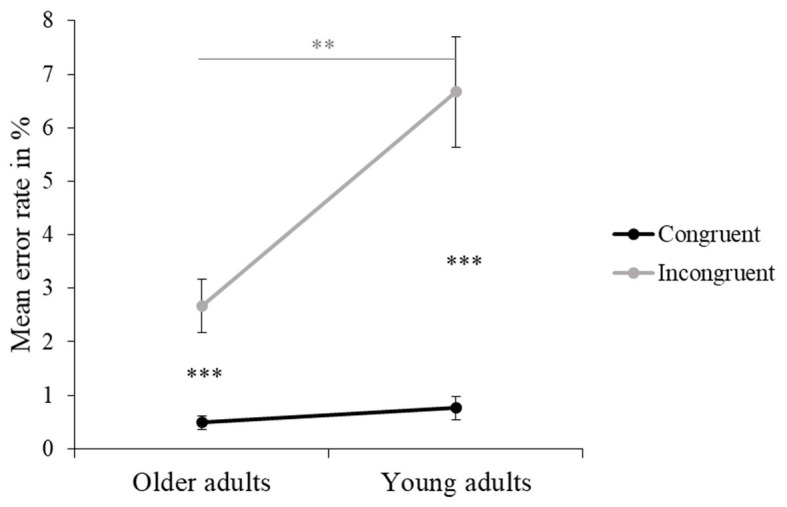
Interaction between Age Group and Flanker Congruency in ER. Mean ER in % (and standard errors) were obtained for congruent and incongruent trials and separately for older and young adults. Values of p (asterisk): **p <0.01 and ***p < 0.001.